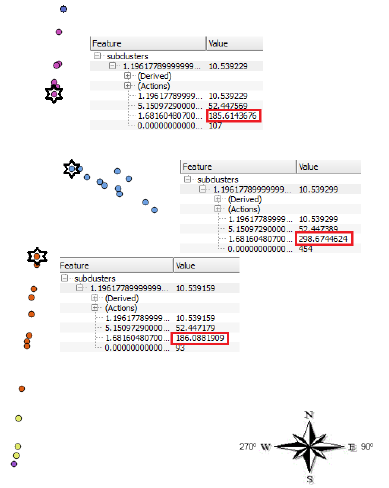
Figure 8. Representatives of the clusters are symbolized with six-pointed stars. On their right are given their coordinates and the heading of their movement (red rectangle)